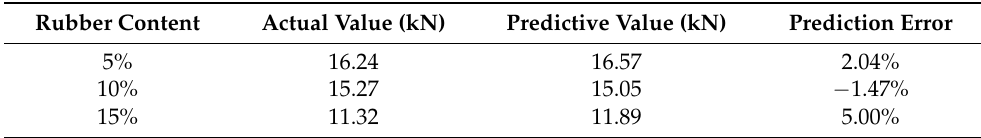
Table 13. Peak frequency (10) single-parameter neural network prediction